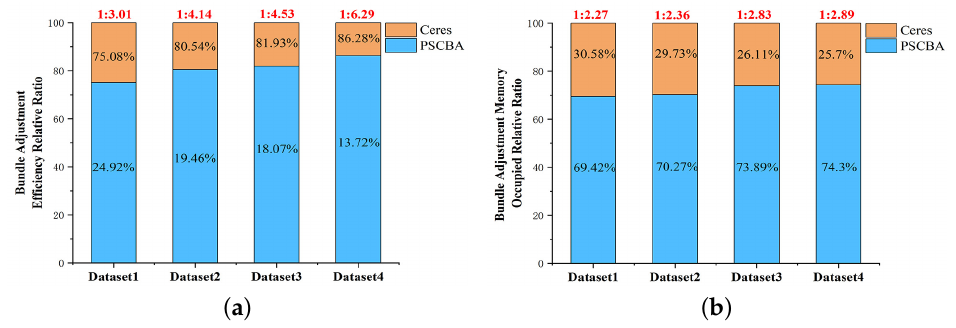
Figure 15. Bundle adjustment efficiency and memory relative ratio. ( a ) BA efficiency relative